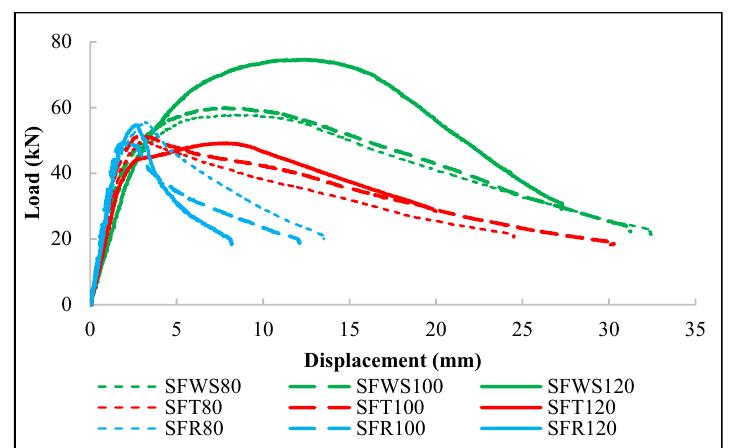
Figure 2. Load-displacement curves.